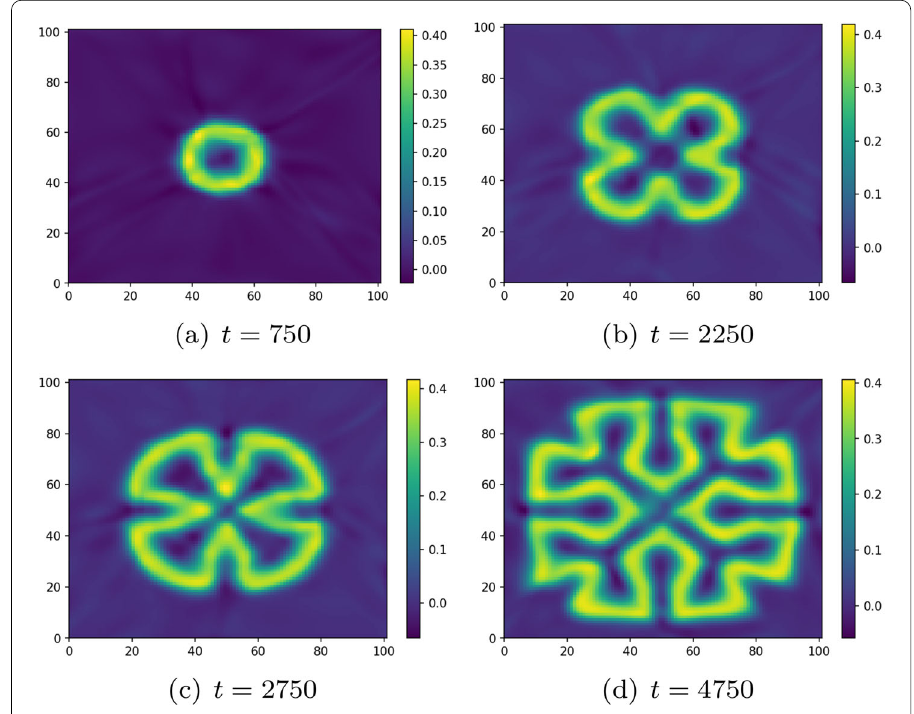
Fig. 6 Example of Flowerpatterns . The parameters used in the (3) are F = 0 . 055 and K = 0 . 062. The times shown are: t = 750 , 2250 , 2750 ,